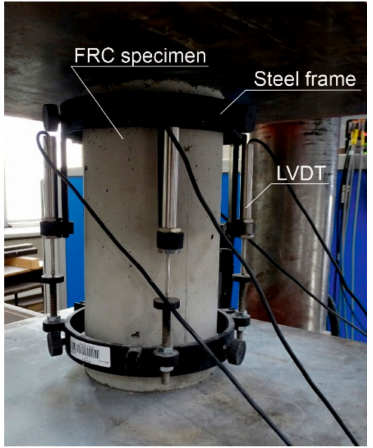
Figure 2. The compression test of the FRC specimen.